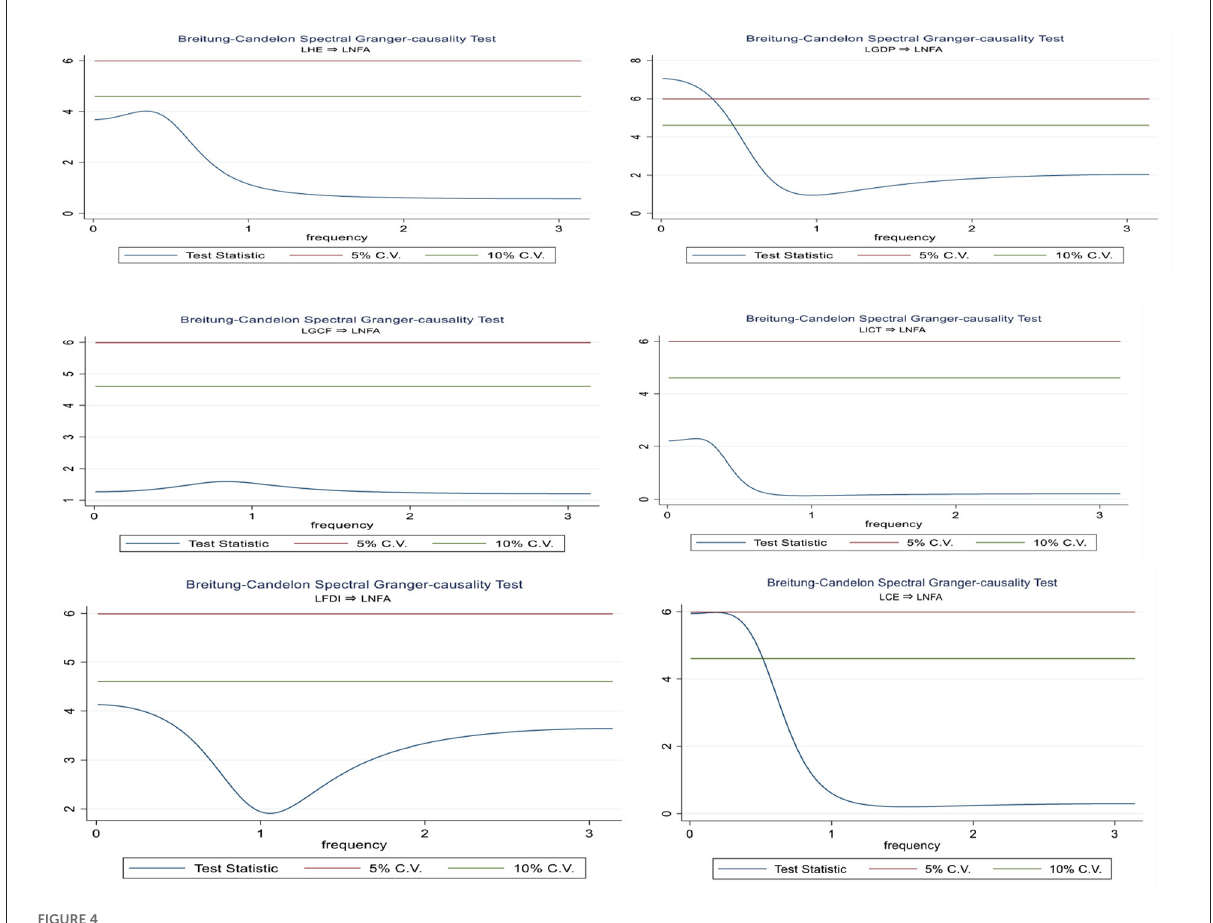
FIGURE4 Graph for causality